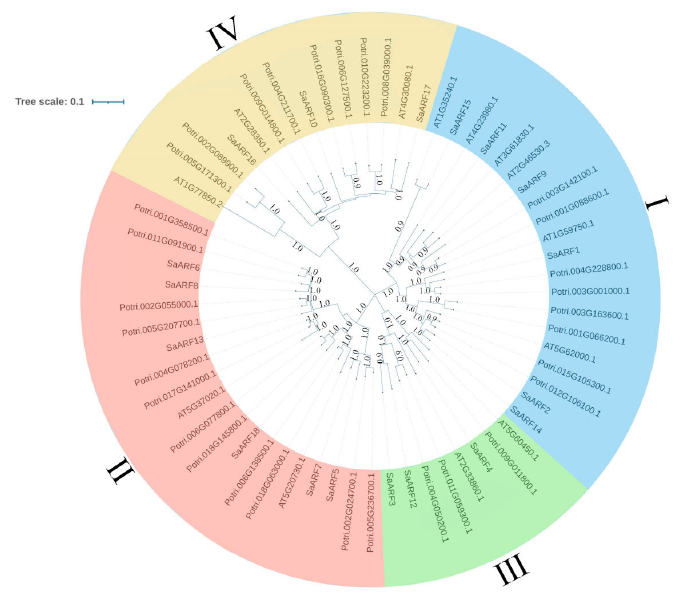
Figure 4. Phylogenetic relationships of ARF gene family members in Arabidopsis thaliana , Populus trichocarpa and sandalwood. The MEGA X program in the NJ connection method was used to construct a phylogenetic tree, which was used to perform beautification (https://itol.embl.de/itol.cgi, accessed on 16 August